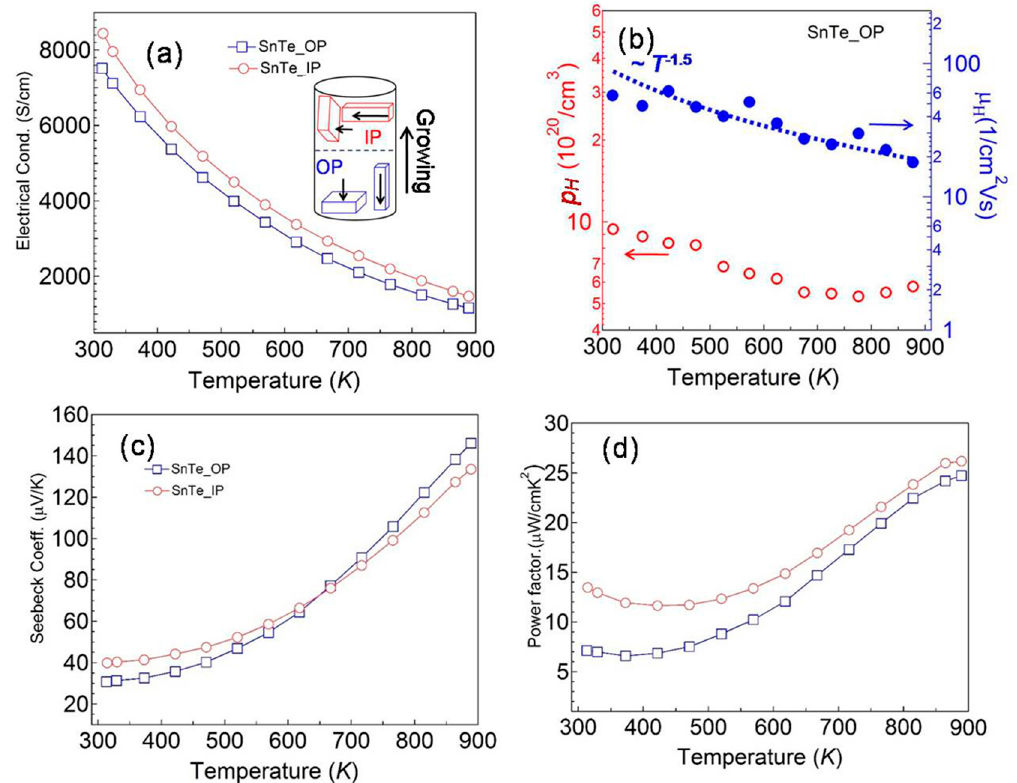
Figure 2. Temperature dependence of electrical transport properties ( a ) electrical conductivity; ( b ) carrier concentration and mobility; ( c ) Seebeck coe ffi cient; ( d ) power factor for SnTe quasi crystal. The inset figure in (a) shows the schematic diagram of measuring